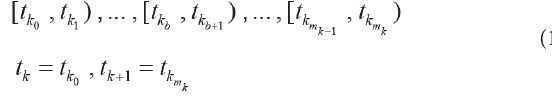
figure 2. Graph of “regular pentagon” formation